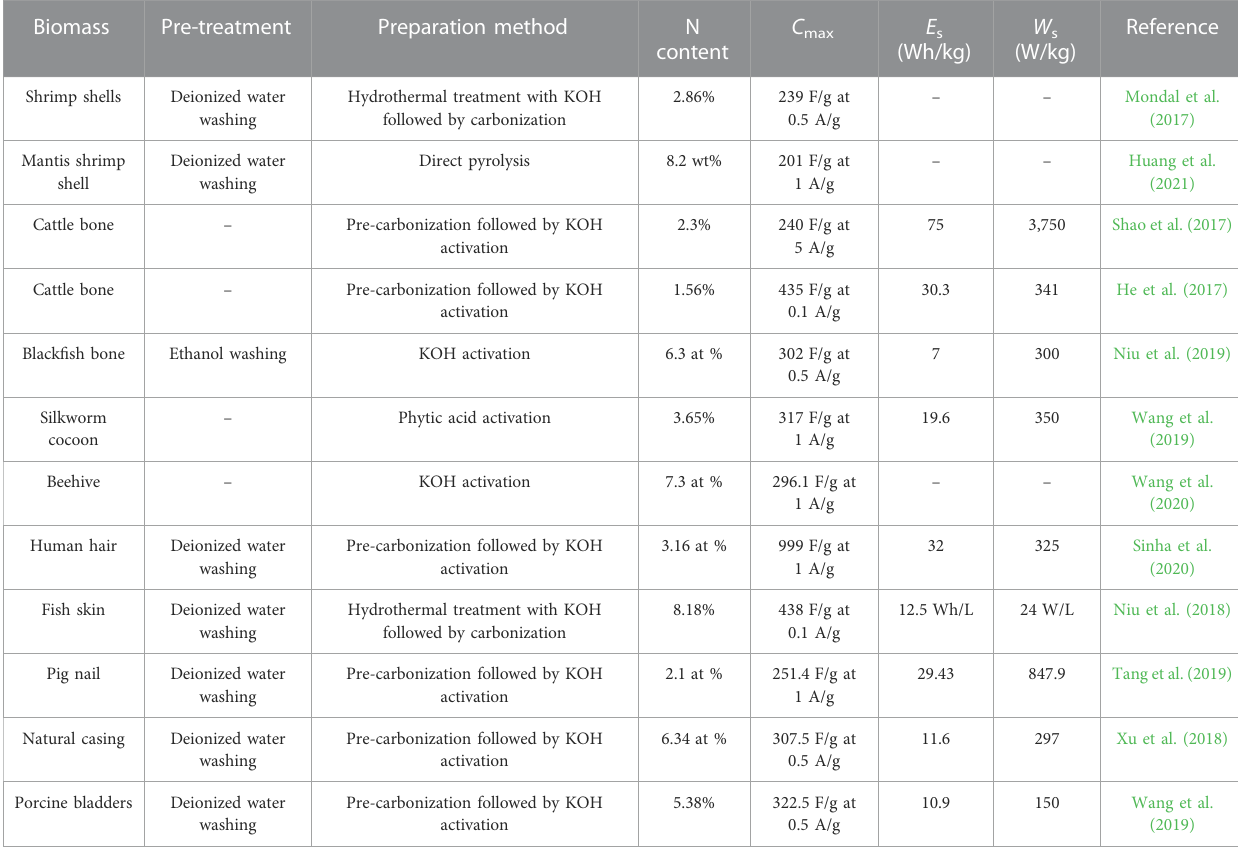
TABLE 2 Animal-based N self-doped biochar applications in supercapacitors.